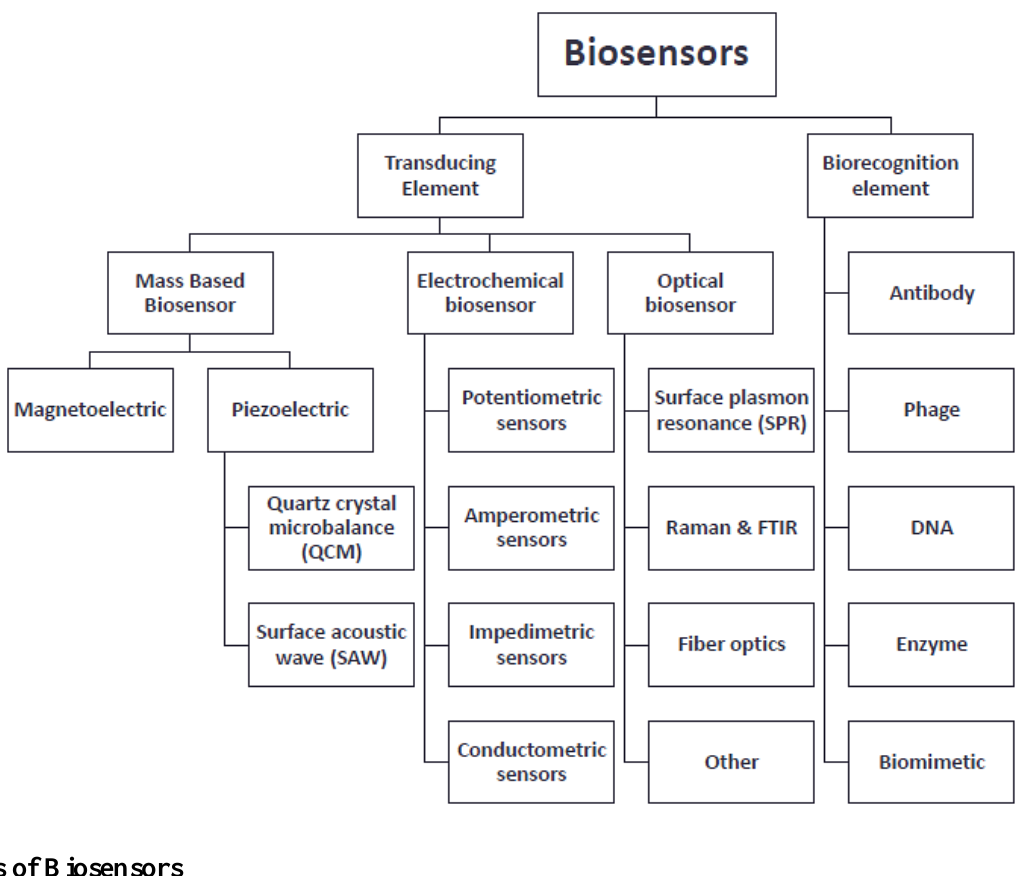
Figure 4. Schematic representing the classifications of biosensors. (Contents adapted from